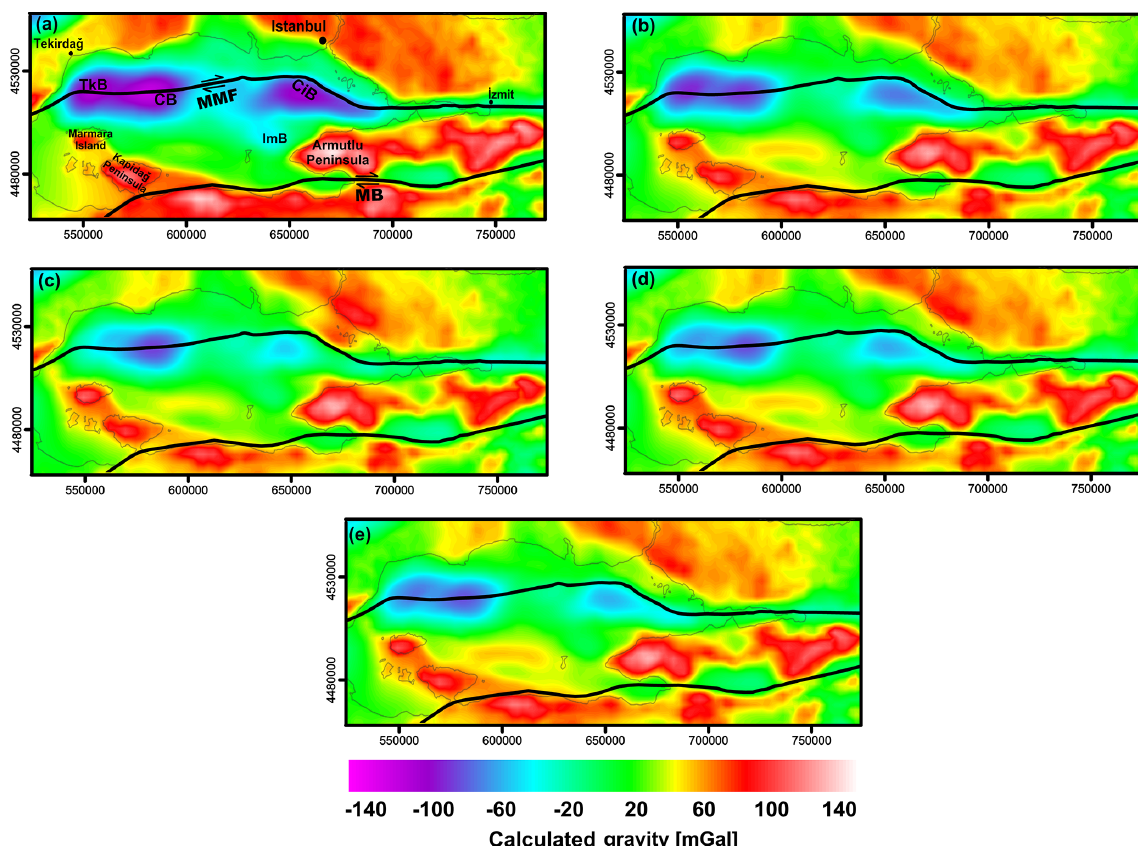
Figure 7. Calculated gravity over the model area (WGS84, UTM zone 35 ◦ N). (a) Initial model gravity response. (b) Gravity response of a model with differentiated crust based on the seismic observations (Fig. 4); (c) Gravity response of Model I, the best-fit model based on the forward gravity modeling on EIGEN-6C4 (Förste et al., 2014). (d) Gravity response of Model II, the best-fit model based on the forward gravity modeling in Improved-TOPEX (Kende et al., 2017). (e) Gravity response of Model III, the alternative best-fit model based on the forward gravity modeling in Improved-TOPEX (Kende et al., 2017). The average density for the modeled high-density bodies is 3150kgm − 3 in Model I and Model II and 2890kgm − 3 in Model III. The corresponding residual gravity anomaly of each model is shown in Fig.